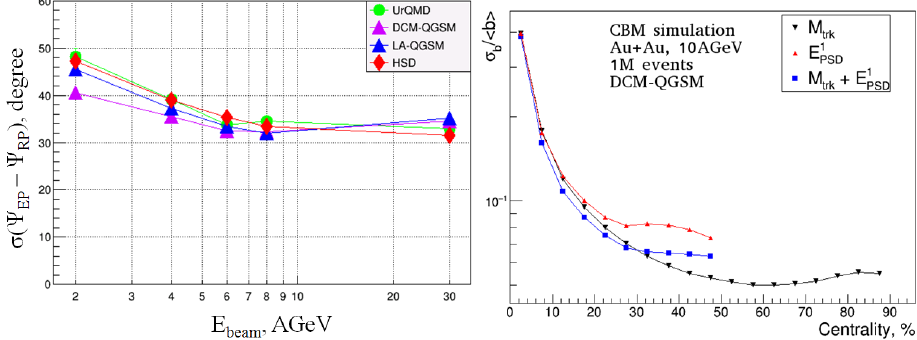
Figure 3. (Left) Reaction plane resolution vs beam energy for various collision models, 100K events were generated for every energy and every model. (Right) Impact parameter resolution for di ff erent centrality estimators, 1M events of 10 AGeV Au + Au collisions were generated with DCM-QGSM